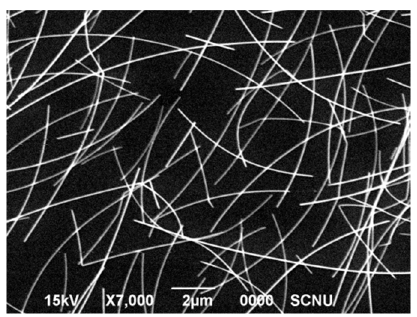
Figure 2. SEM image of Ag nanowires used in the experiment.